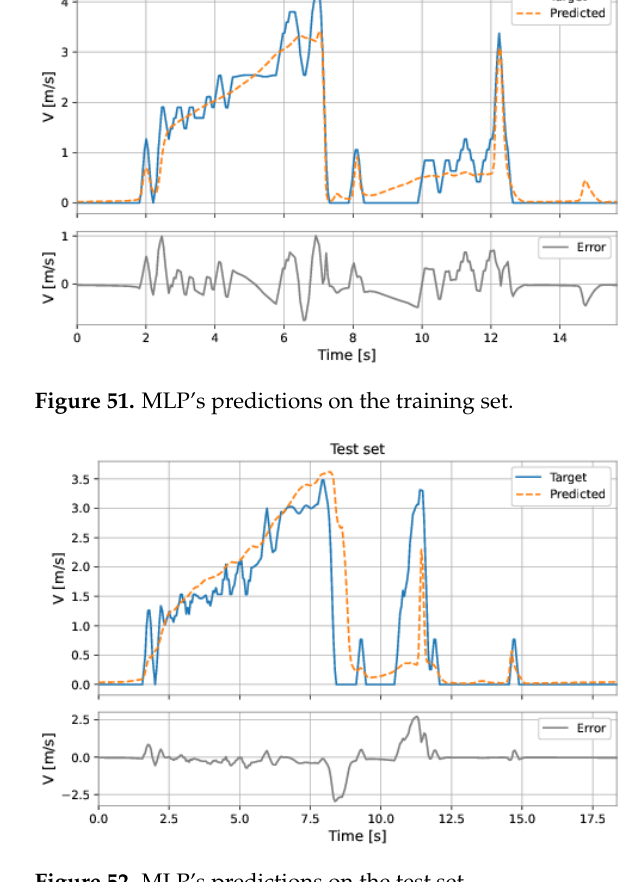
Figure 52. MLP’s predictions on the test